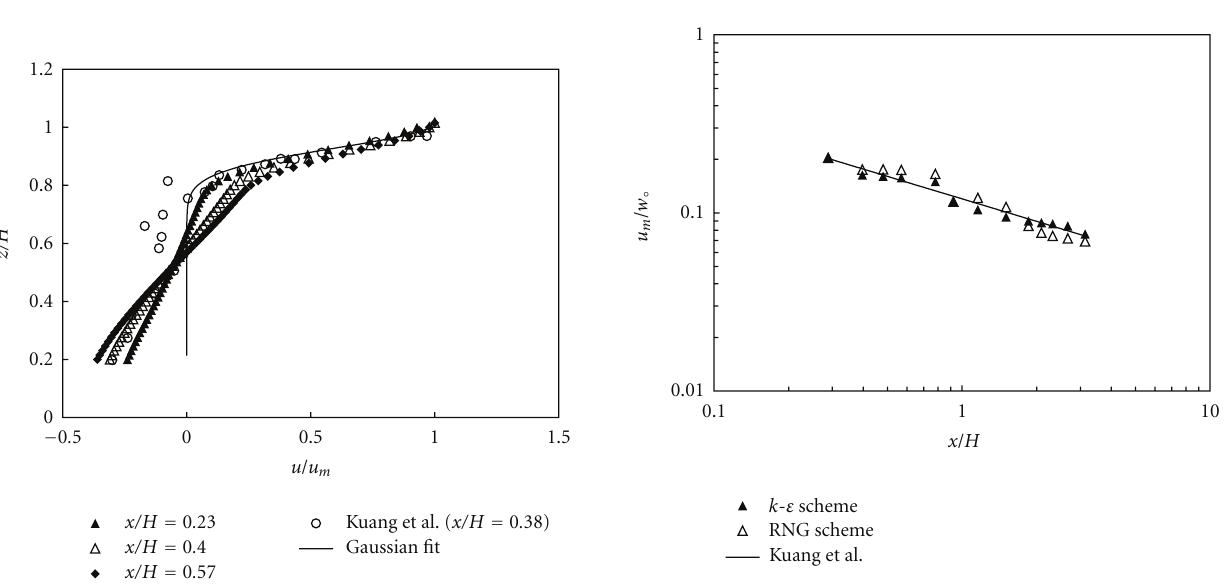
Figure 14: Profiles of lateral velocity in ZHJ ( k - ε scheme).